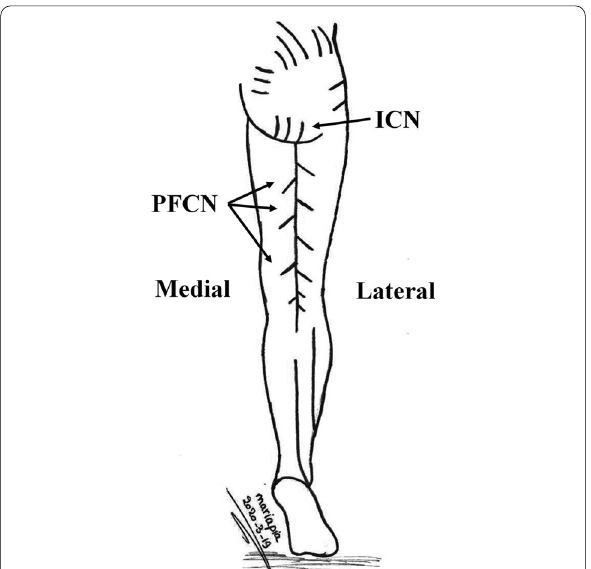
Fig. 1 Terminal anatomical course of posterior femoral cutaneous nerve on the posterior aspect of the thigh [4–6, 8]. ICN, inferior cluneal nerve; PFCN, posterior femoral cutaneous nerve